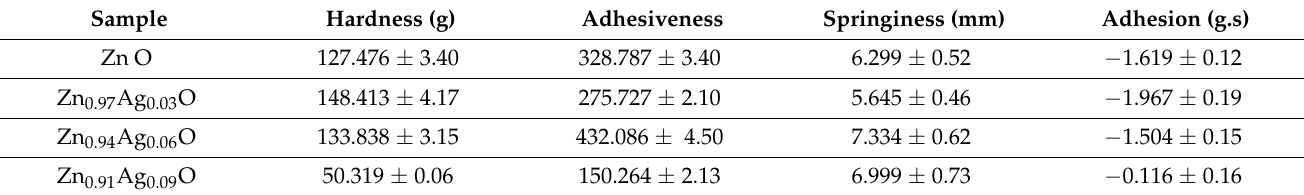
Table 3. Effect of Ag nanoparticles on the textural characterization of κ -Carrageenan in the hydrogel. Sample Hardness